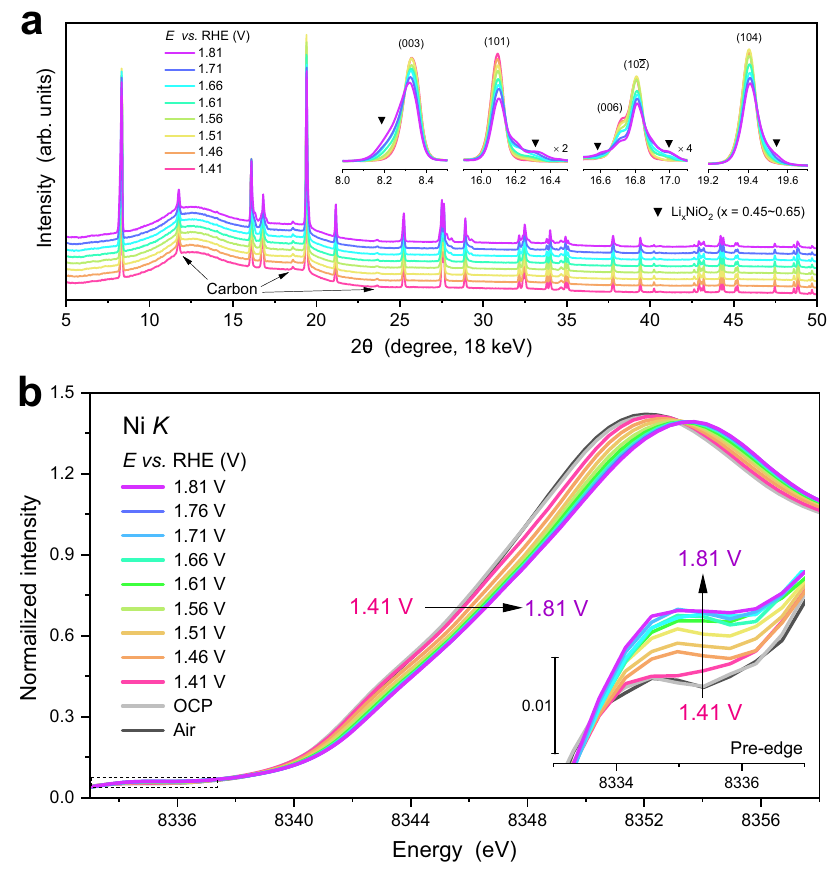
Fig. 5 | LiNiO 2 delithiation under OER conditions. a Operando XRD patterns and b Operando Ni K edge XANES spectra of LiNiO 2 under applied potentials of 1.41 – 1.81Vin1MKOHsolution.Diffractionpeaksinlow2 θ rangesandthepre-edge